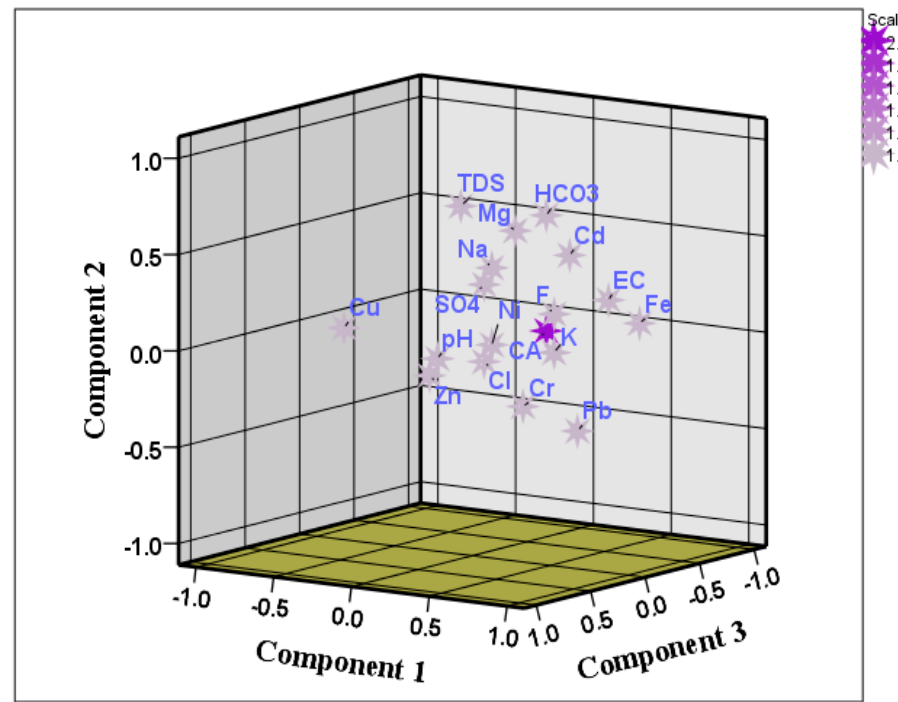
Figure 6. Principal component analysis for physicochemical parameters and heavy metal concertation in groundwater.